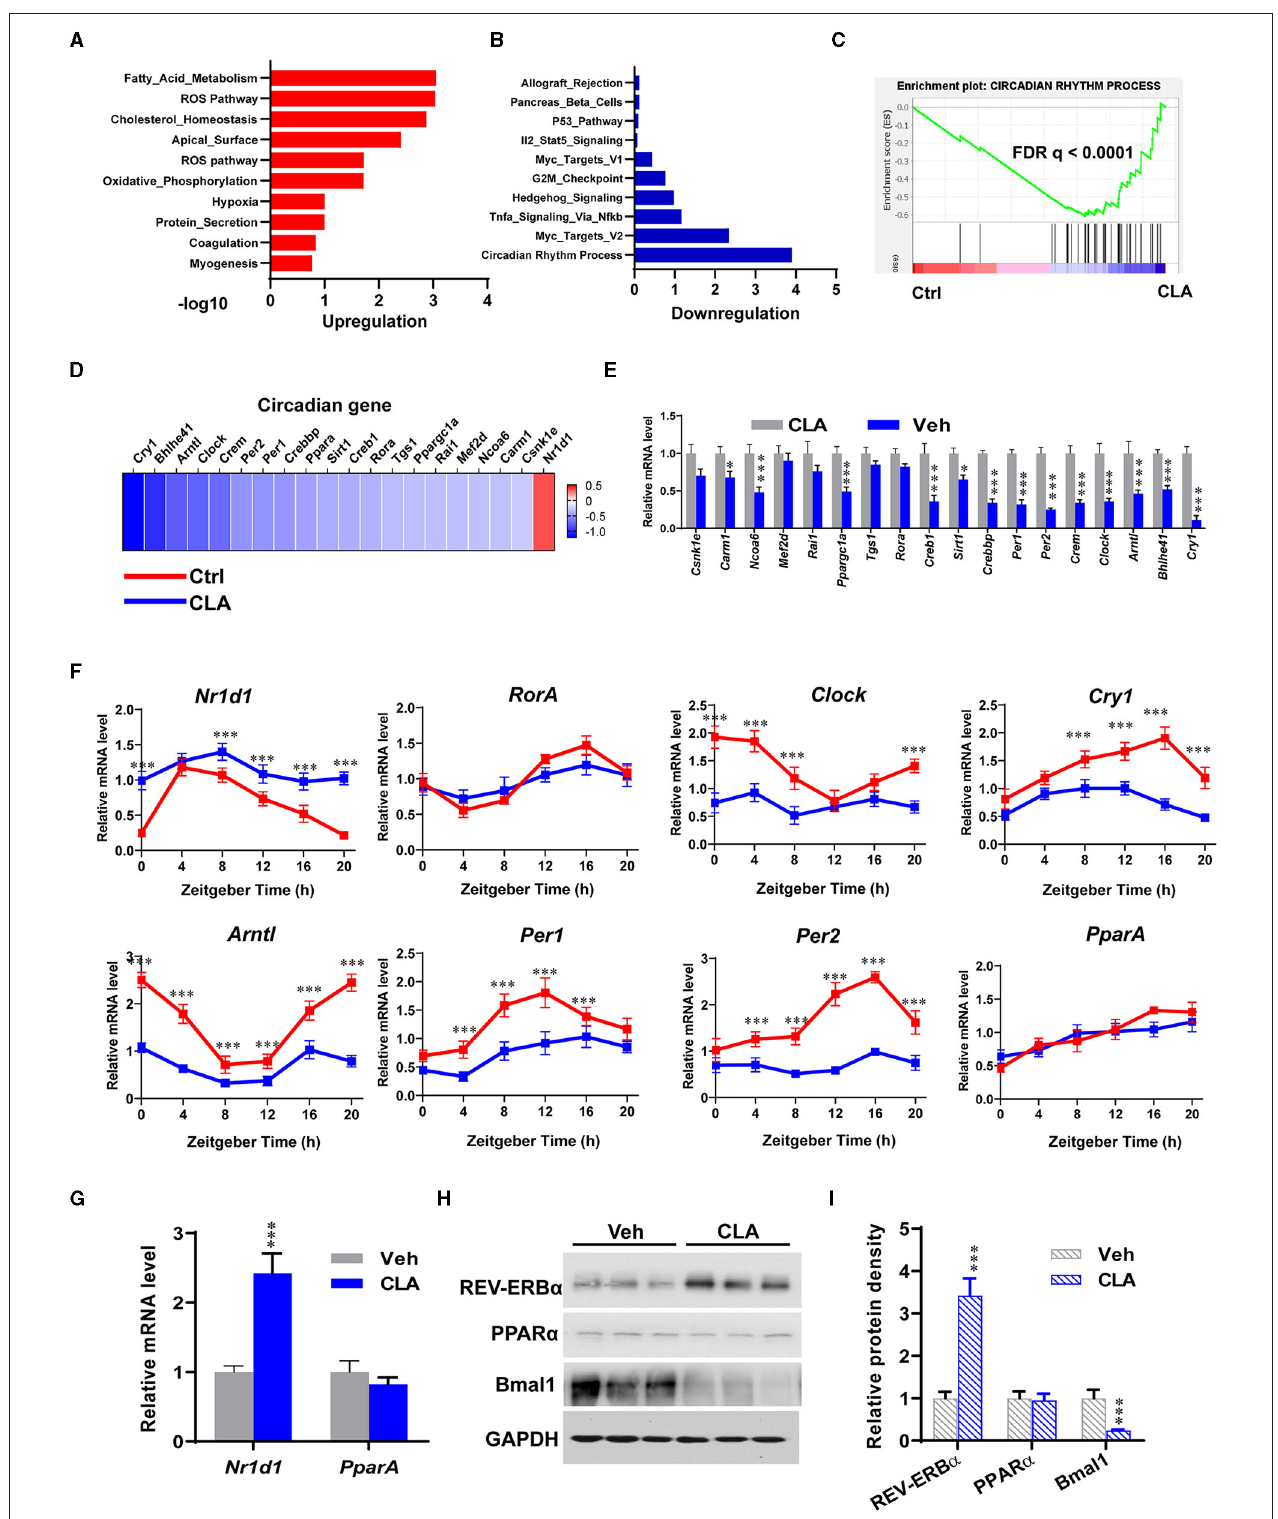
FIGURE 2 | Dietary CLA disrupts the circadian clock gene program in the liver. Gene ontology analysis of the upregulated (A) and downregulated (B) genes in the livers of CLA mice compared to that of the control groups. Hypergeometric test and Benjamini-Hochberg p -value correction was applied. (C) GSEA plots depicting the enrichment of genes downregulated in the circadian rhythm process of livers from CLA-treated mice compared to the controls. FDR, false-discovery rate. (D)